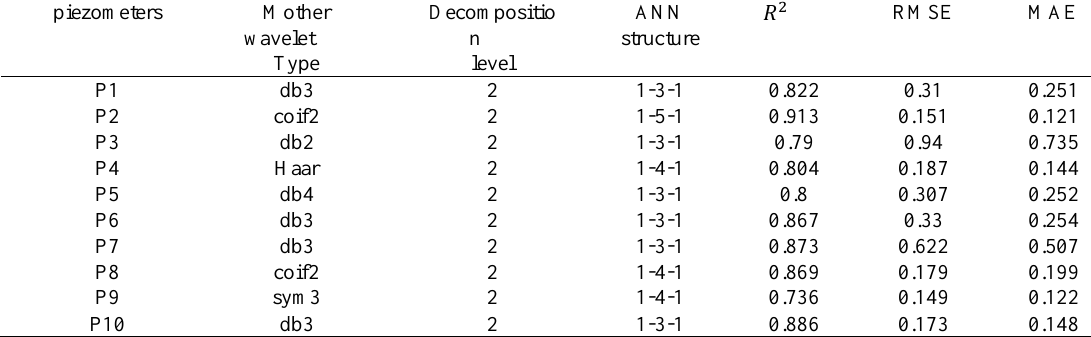
Table 7 . 𝑅 2 , RMSE and MAE in GWL prediction by the WANN model in the testing period . piezometers Mother wavelet